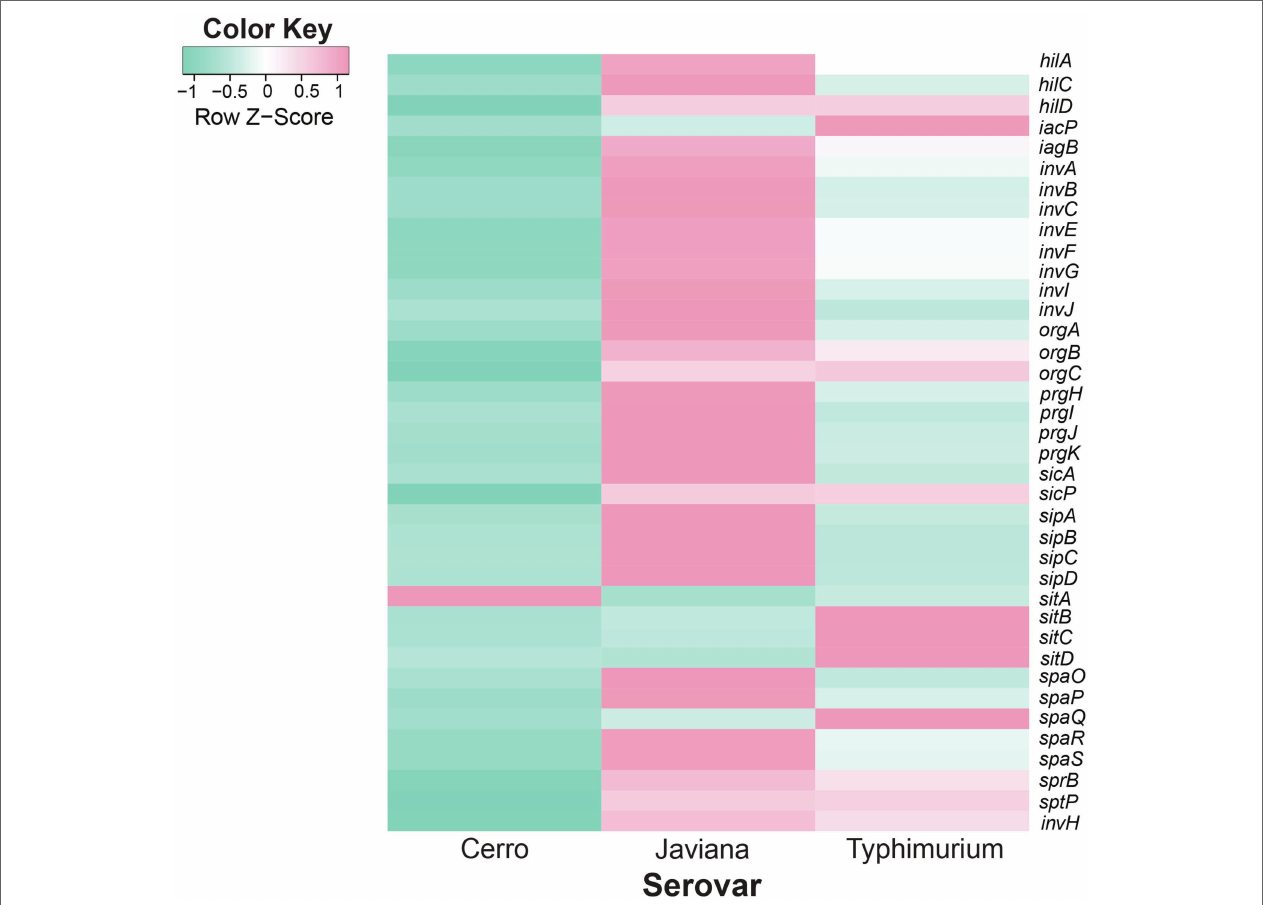
FIGURE 4 | Inter-serovar comparisons demonstrate that SPI-1 transcript abundances are higher in serovars Javiana and Typhimurium compared to Cerro. Comparison of transcript abundances of genes in the SPI-1 locus. Transcript abundances were averaged from three biological replicates per strain ( S. Cerro FSL R8-2349, S. Javiana FSL S5-0395, and S. Typhimurium ATCC 14028S). z-scores represent the number of standard deviations that a given strain’s transcript abundances differ from the transcript abundances across all strains for that